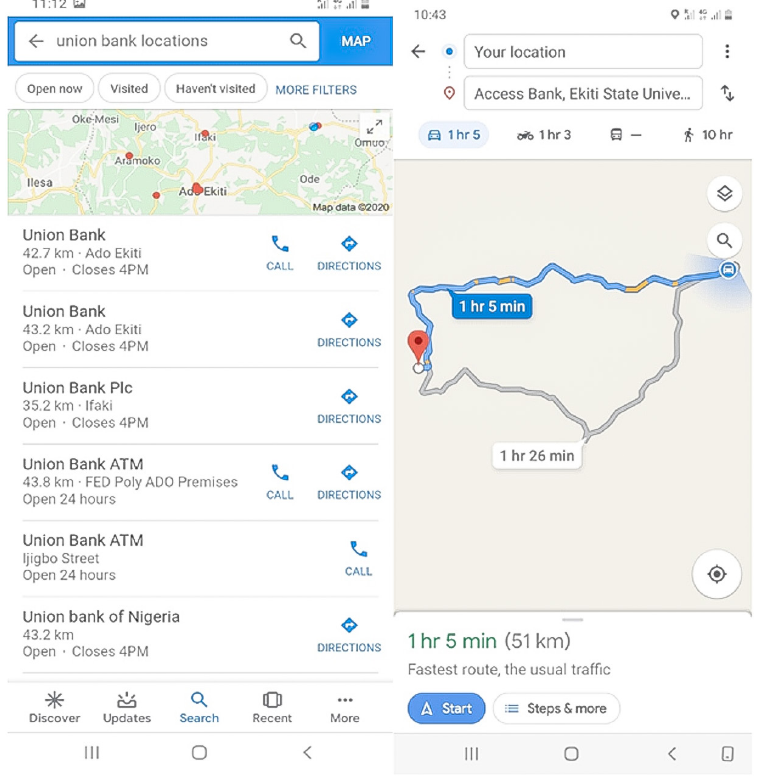
Figure 1. Banking halls and services availability in some Local Government of Ekiti